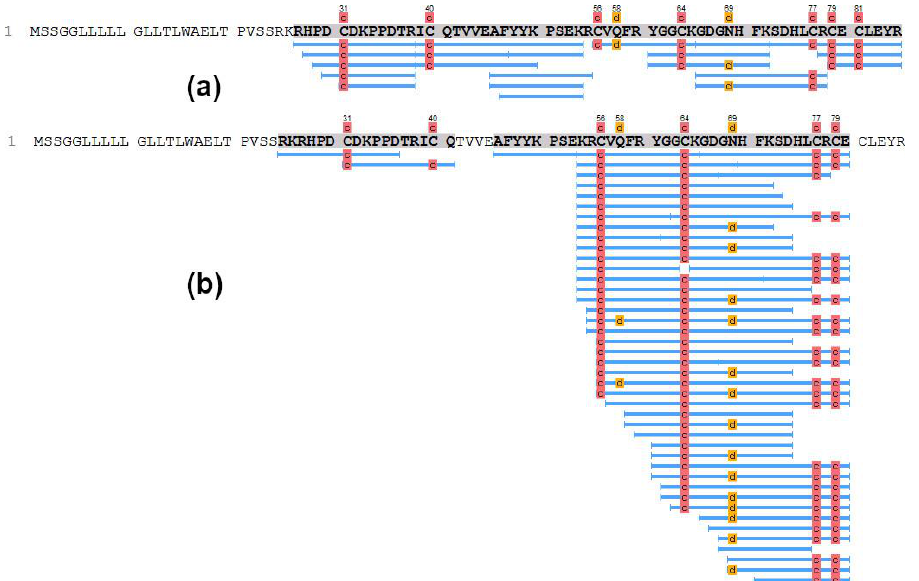
Figure 8. Peptide mass fingerprinting for the protein of fraction IV-18-2. The peptides found in tryptic ( a ) and Glu-C ( b ) digests and matching the shown amino acid sequence are indicated by blue lines. C on the red background shows carbamidomethylated cysteine residues and d on the yellow background shows aspartic acid produced by deamidation of asparagine. The amino acid sequence is for the B-chain (gi|82207097) precursors of β -Bgt, in which Arg45 was replaced by Glu and Asn67 by Asp.